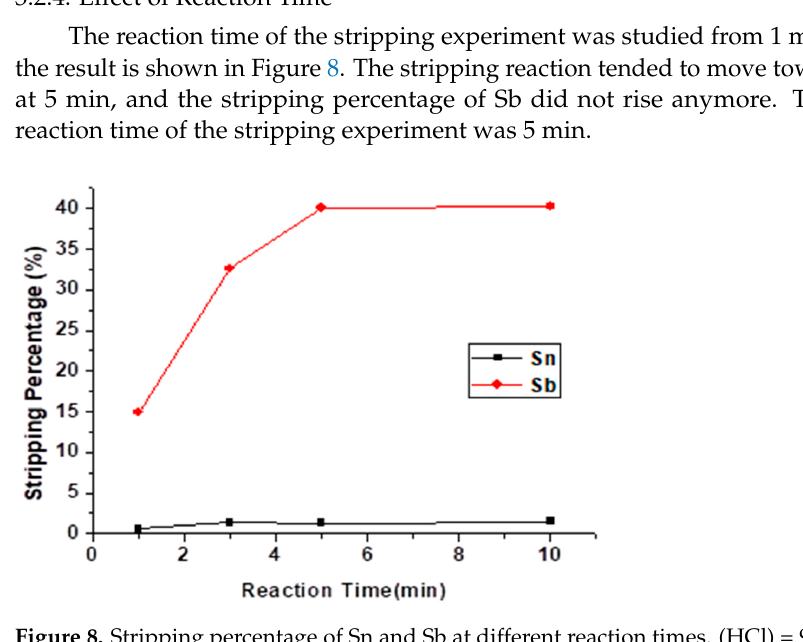
Figure 7. Stripping percentage of Sn and Sb at different O/A ratios. (HCl) = 9 M, Reaction time = 5 min.